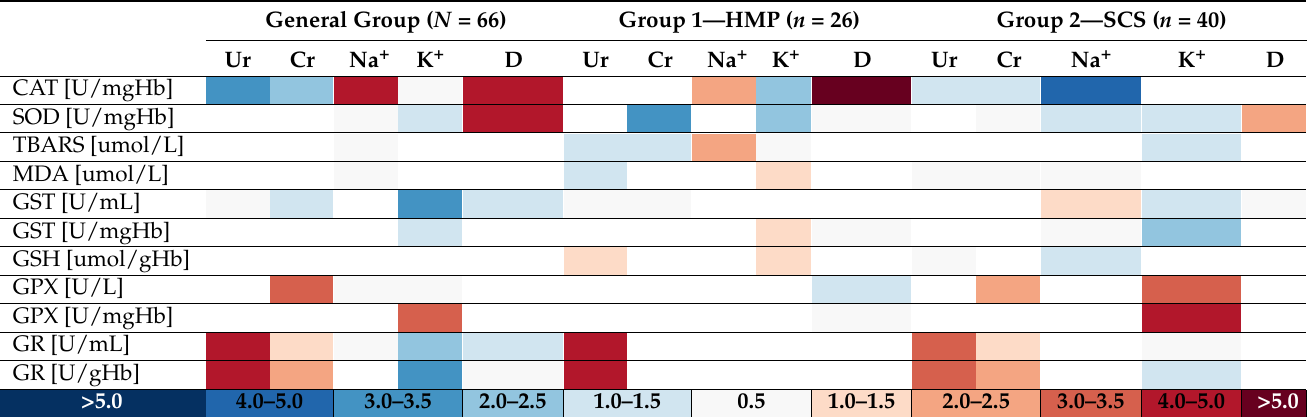
Table 6. Heatmap of matrix correlations between oxidative stress biomarkers and kidney function parameters in repeated measurements (Ur—urea, Cr—creatinine, Na + —sodium, K + —potassium, D—diuresis) with aggregation intensity color